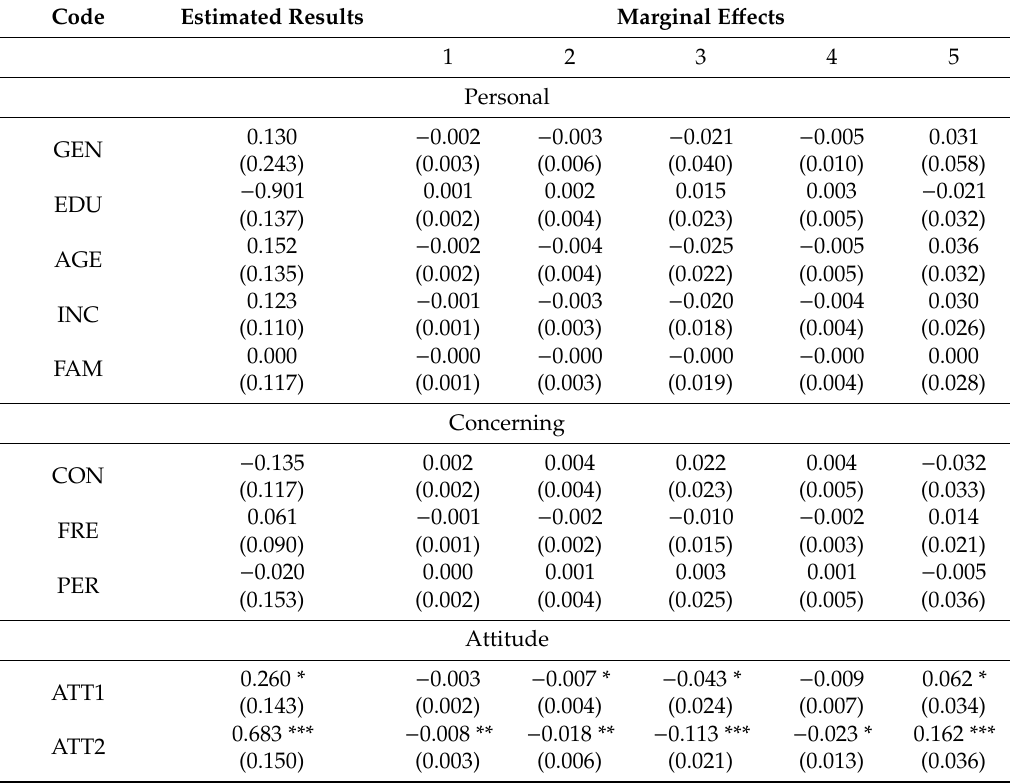
Table 3. Estimated results and marginal e ff ects of